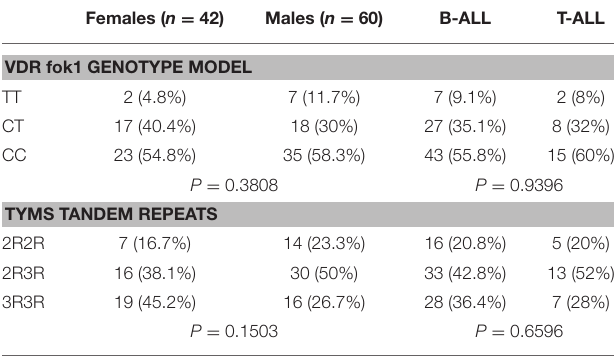
TABLE 1 | Contingency analysis of VDR fok1 and TYMS tandem repeats among gender and ALL subtypes. Females ( n = 42) Males ( n = 60) B-ALL T-ALL